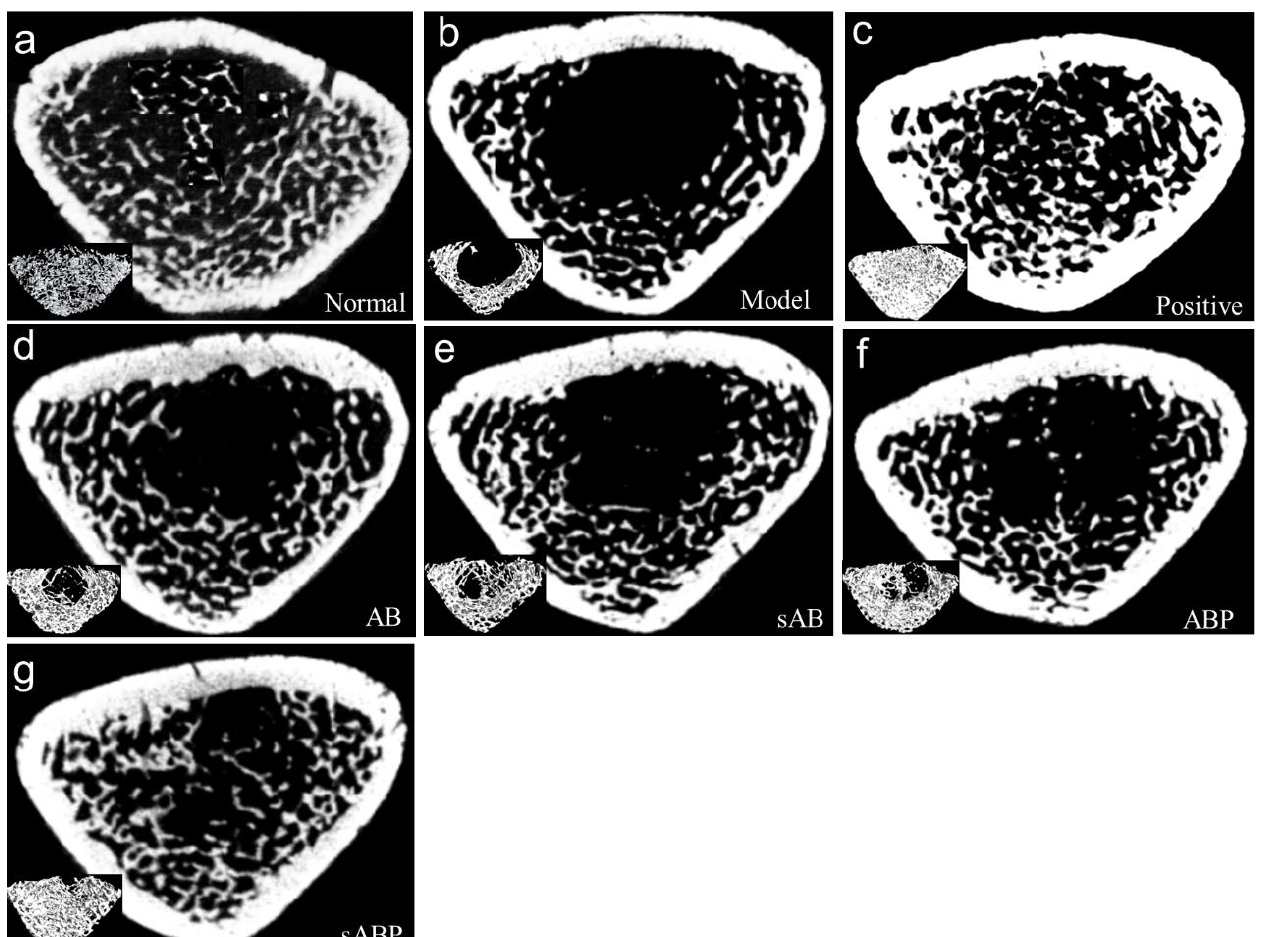
Figure 3. Representative 2D and 3D mapping architectures of trabecula bone of different groups: ( a ) normal group, ( b ) model group, ( c ) positive group, ( d ) polysaccharide knockout component of crude AB-treated group, ( e ) polysaccharide knockout component of salt-processed AB-treated group, ( f ) polysaccharide component of crude AB-treated group, ( g ) polysaccharide component of salt-processed AB-treated group.